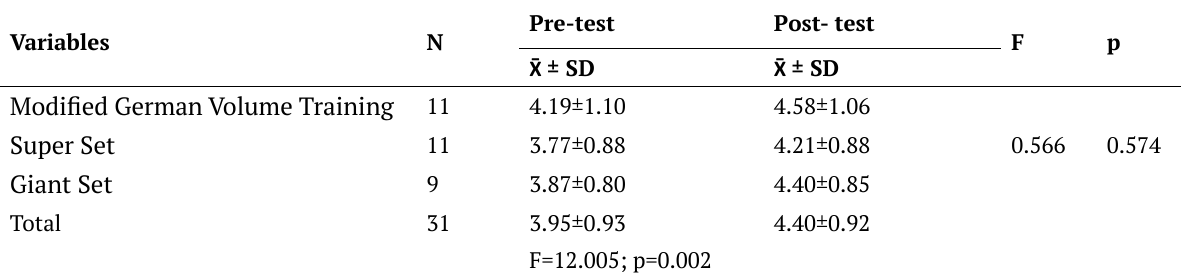
Table 5. Pre-test and post-test comparison of pec major area values of the groups